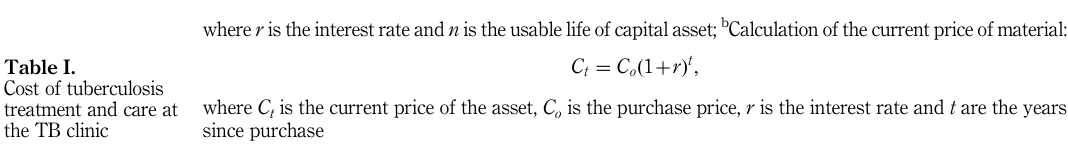
treatment and care at the TB